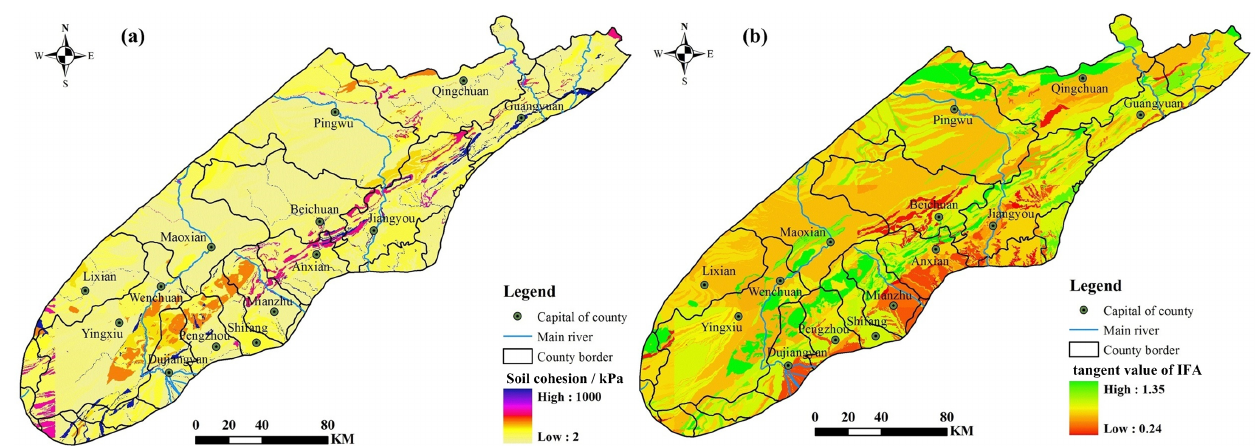
Figure 6. (a) Distribution of the soil cohesion values/kPa; (b) distribution of the tangent value of internal friction angle (IFA).